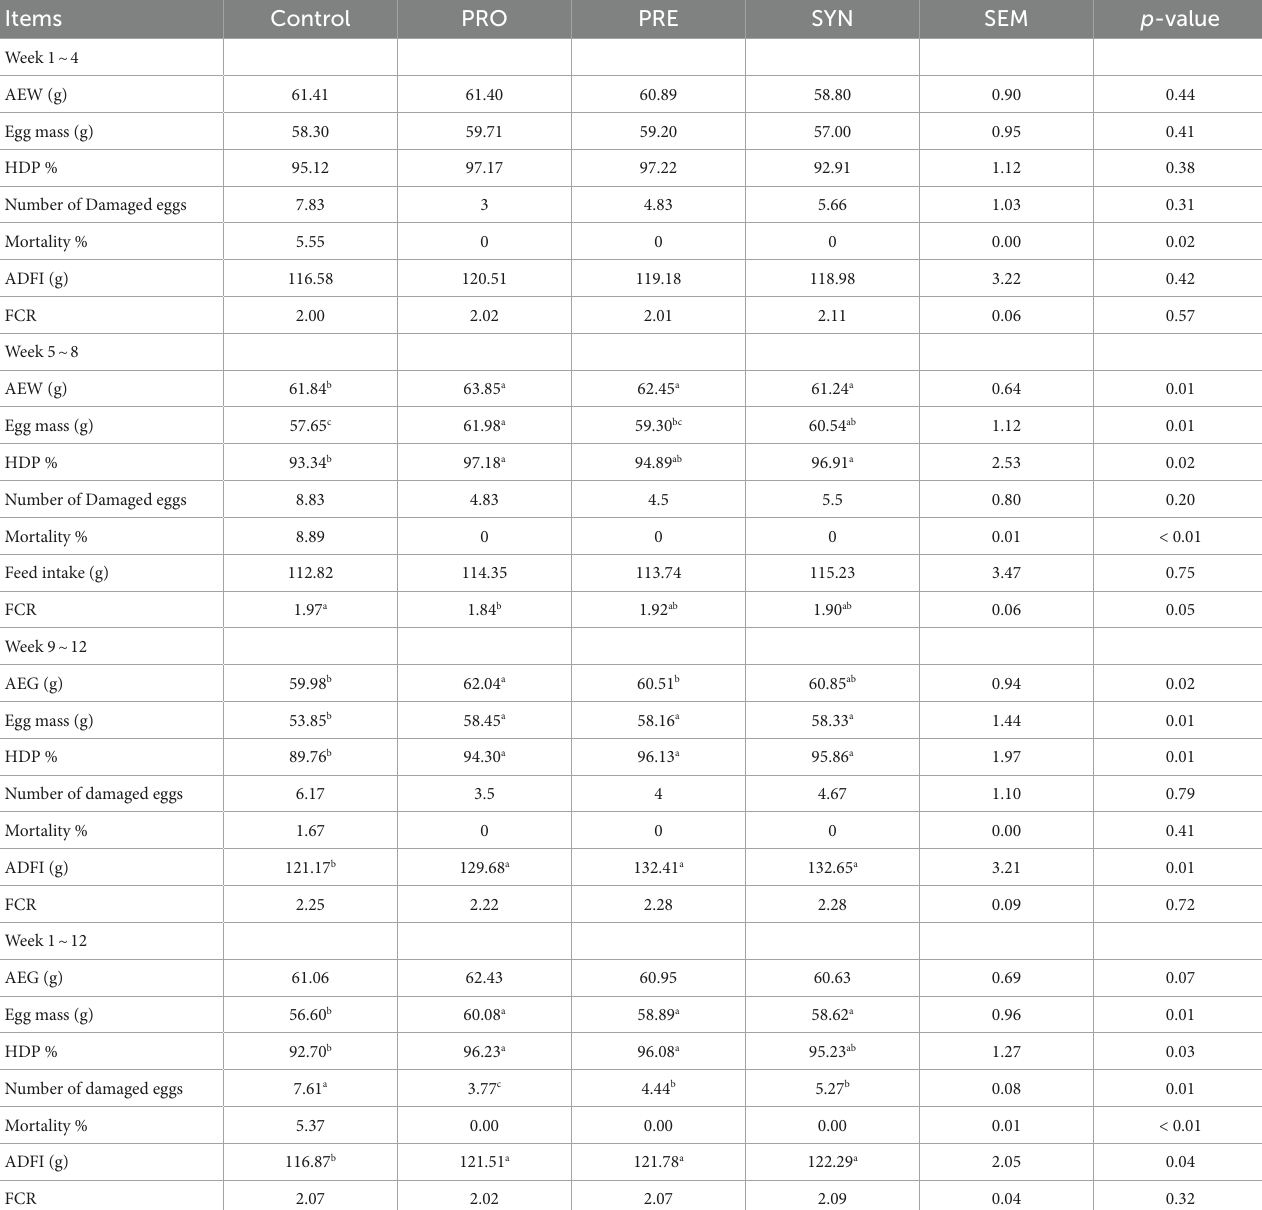
TABLE 2 Effects of dietary treatments on the performance of laying hens. Items